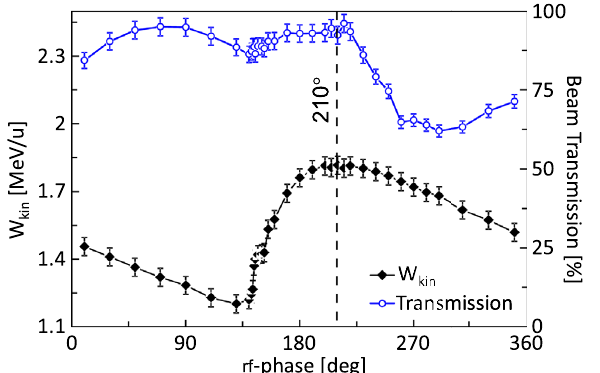
FIG. 15. Phase scan of Ar 6 þ -beam energy for 5 . 5 MV/m.